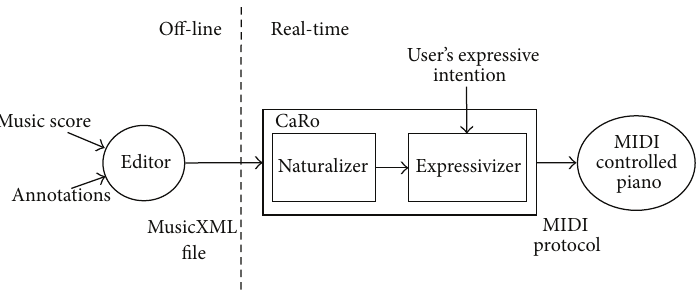
Figure 3: System architecture: CaRo 2.0 receives as input an annotated score in MusicXML format and generates in real-time messages to play a MIDI controlled